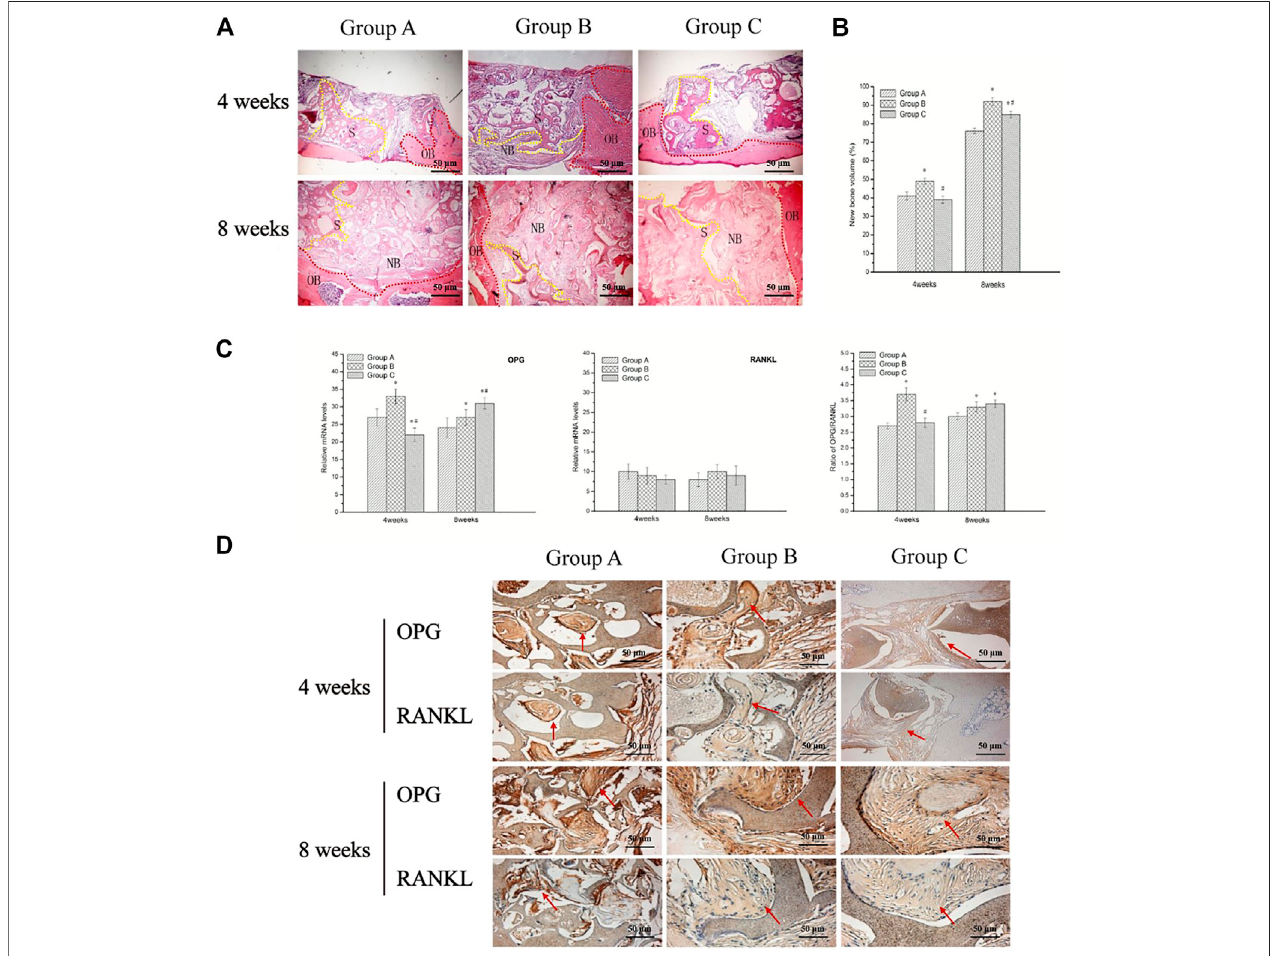
FIGURE 4 | Biocompatibility and bone conduction post-implantation in vivo . (A) Hematoxylin and eosin stained sections of three groups at 4 and 8 weeks post- implantation;NBdenotesnewlyformedbonetissue,Sdenotesscaffoldmaterials(yellow),whileOBdenotesoriginalbone(red).Andthegroupsandtheobservationtime arepresentedinthe fi gure. (B) Newbonevolume(bonearea/porearea × 100%)ofnewlyformedboneatthebonedefectareawasrepairedusingthreegroupsofBMSC/ scaffolds at 4 and 8 weeks after being implanted in vivo . (C) Relative levels of OPG and RANKL mRNA expression, as well as OPG/RANKL ratio in newly formed bonetissuebyRT-qPCR,areshown. (D) ImmunohistochemicallocalizationandreactivityofRANKLandOPGinthenewlyformedboneat4and8 weeksafterimplanted scaffolds (red arrow). * indicates signi fi cant difference from group A ( p < 0.05); # indicates signi fi cant difference from group B ( p < 0.05).